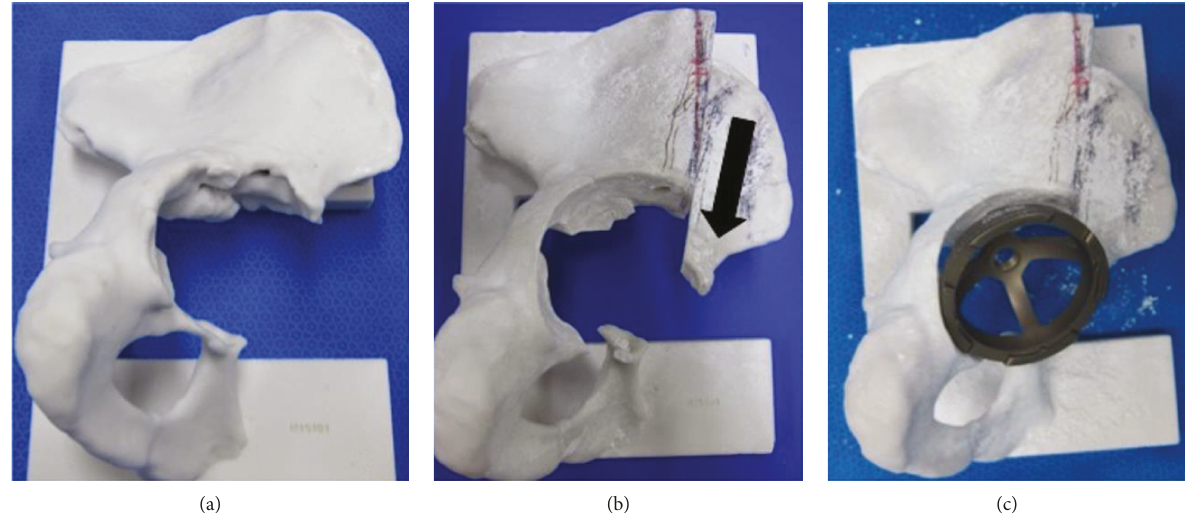
Figure 2: Images from the bone model used for preoperative planning. (a) A bone defect is seen at the acetabulum. (b) We rehearsed the iliac osteotomy and slid the ilium distally (black arrow). (c) The trial cup was placed in the acetabulum.